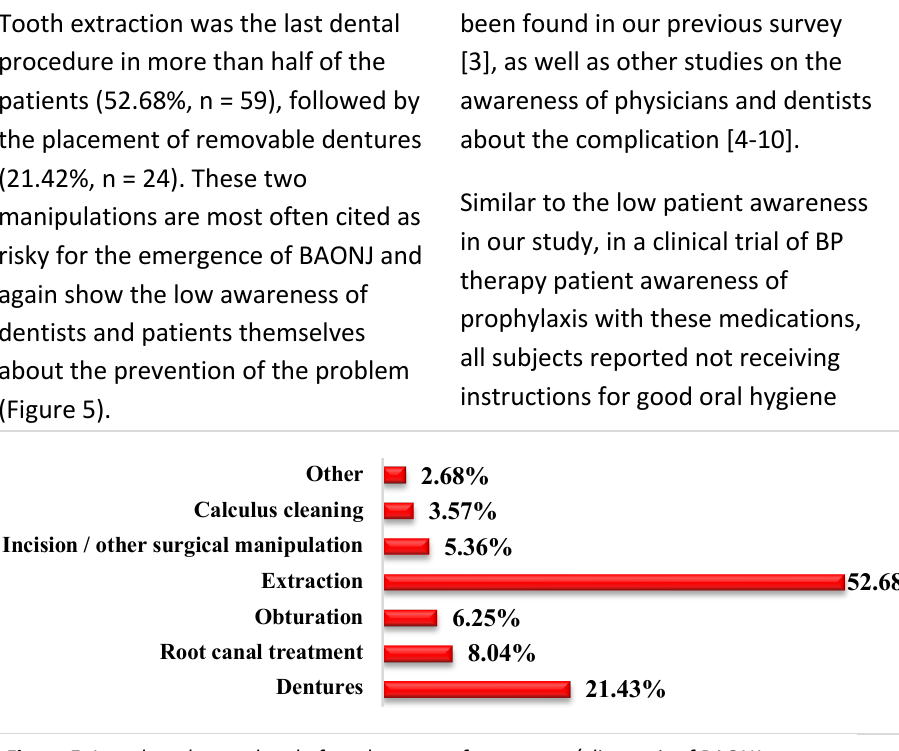
Figure 5. Last dental procedure before the onset of symptoms / diagnosis of